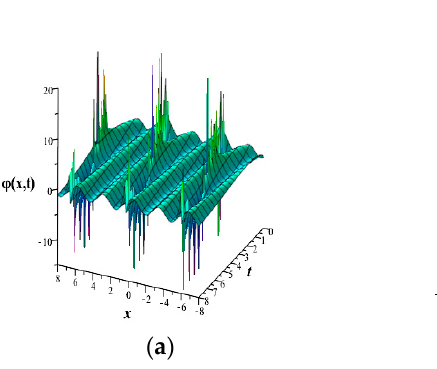
ϕ of Equation (23) for the paramet- ( a ) Complex surface in 3D; ( b ) Complex